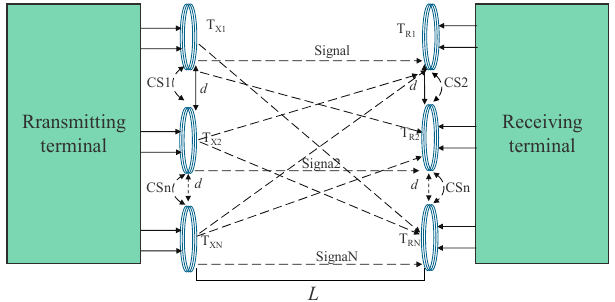
I 2 Figure 1. Principles of magnetic induction communication. The mutual inductance M between the coils can be expressed as (1): (